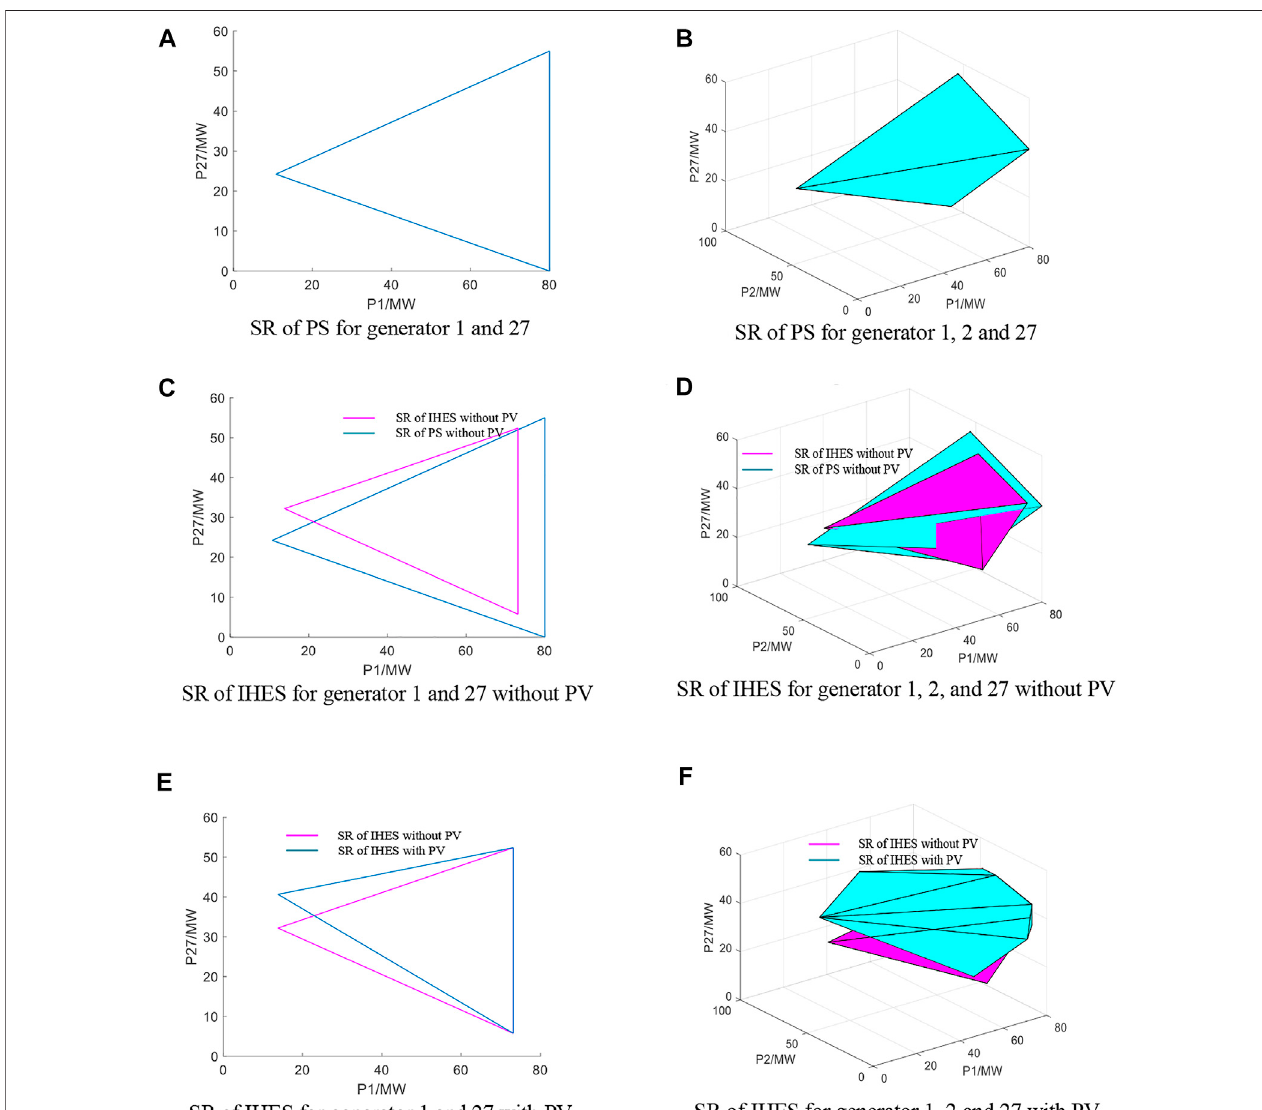
FIGURE 7 | Security region in power system and integrated heat and electricity systems.